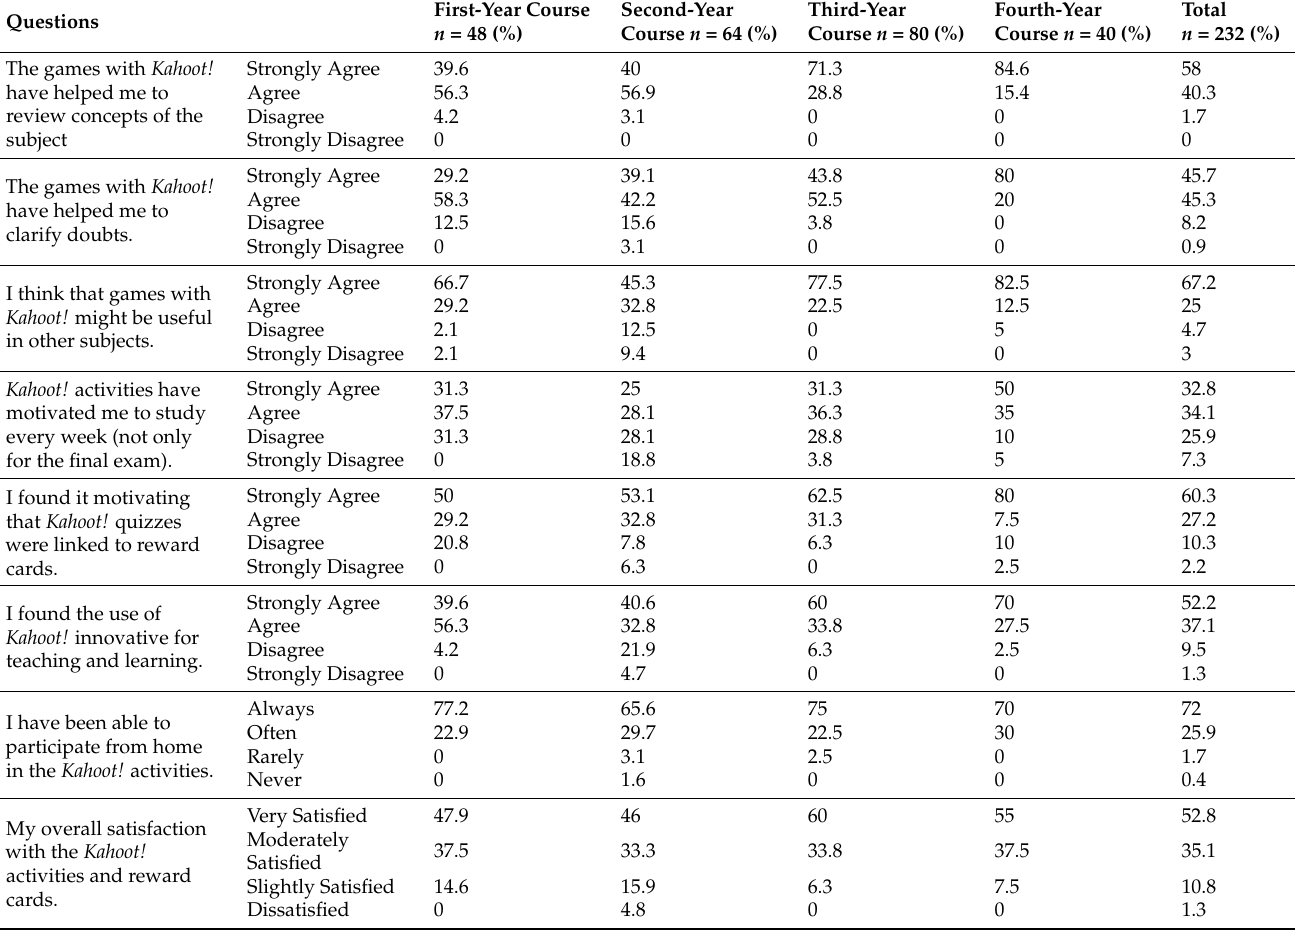
Table 4. Results of the satisfaction questionnaire in each course of the Physiotherapy